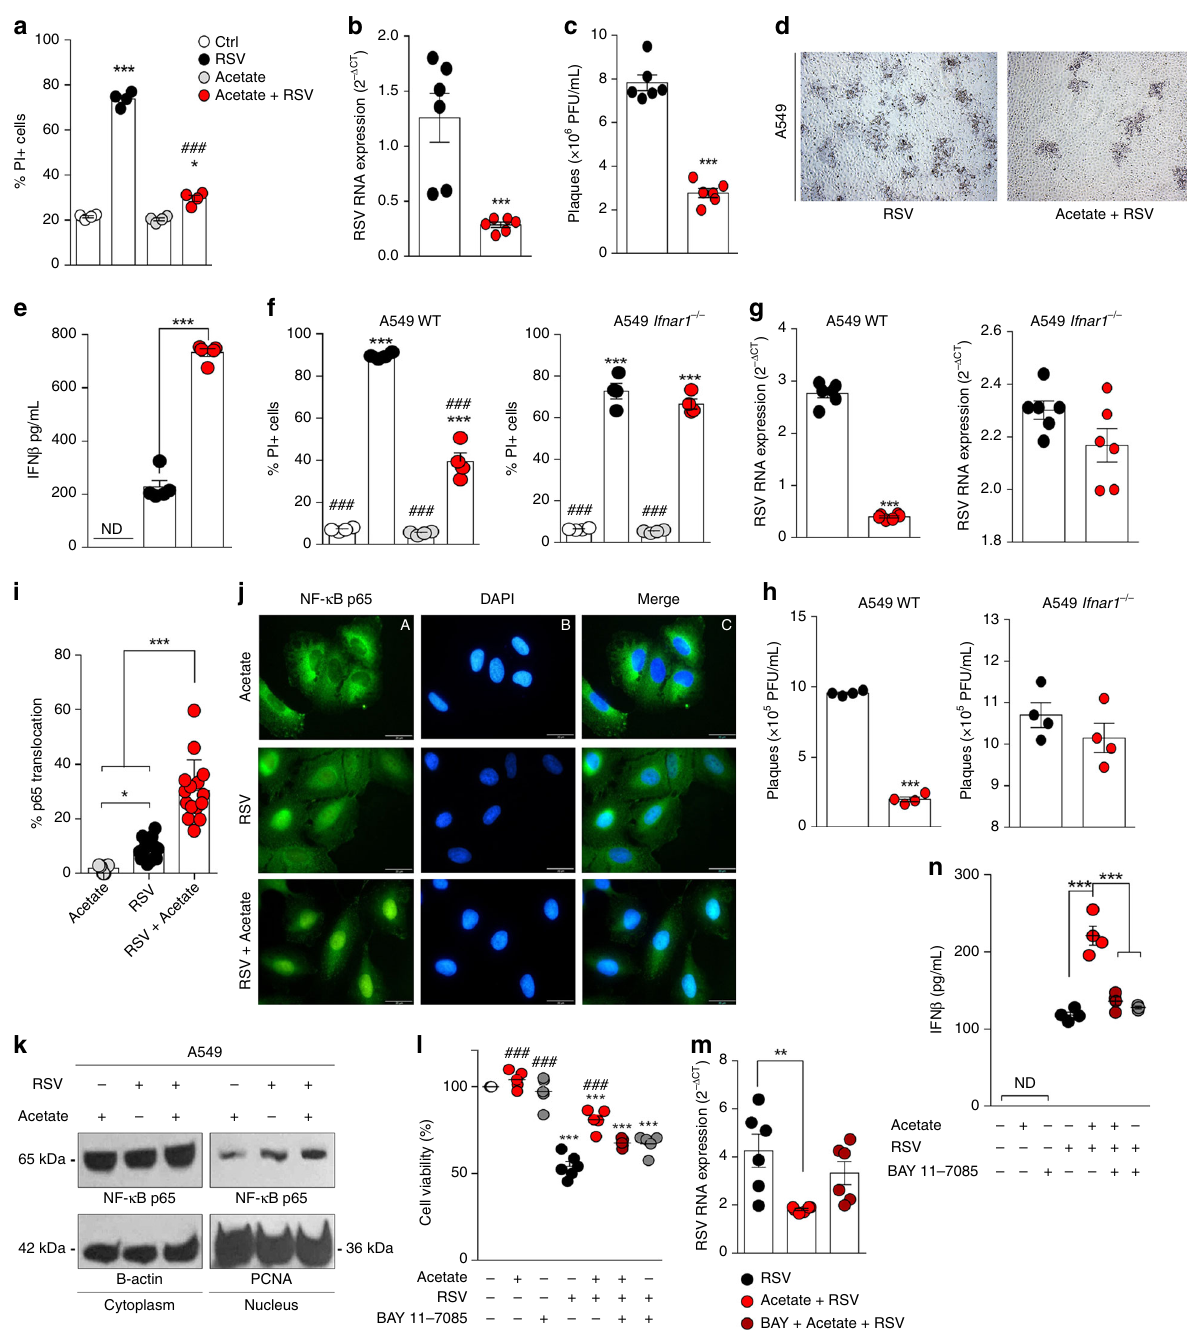
Fig. 6 Acetate treatment mediated IFN- β response in pulmonary cells lines reducing viral load. a – d A549 cells were pre-treated with 260 µ M acetate for 24 h and infected with RSV for 96 h. a Percent of PI (propidium iodide) positive cells detected by fl ow cytometry. b RSV RNA levels detected using real- time PCR (2 - Δ Ct ). c Quanti fi cation of RSV PFUs. d Representative images of viral titration assay indicating viral plaques. Lysis plate titration was